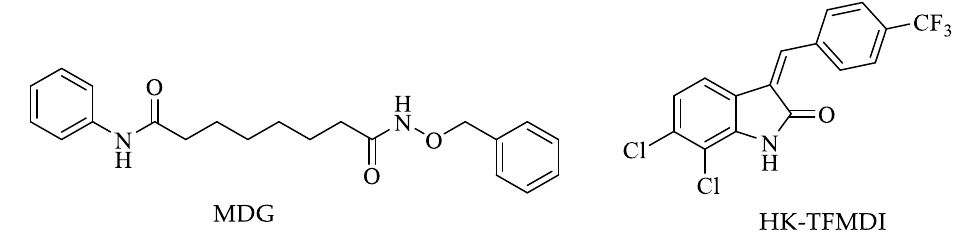
Figure 11. HDAC inhibitor and sirtuin inhibitor active against Leishmania .